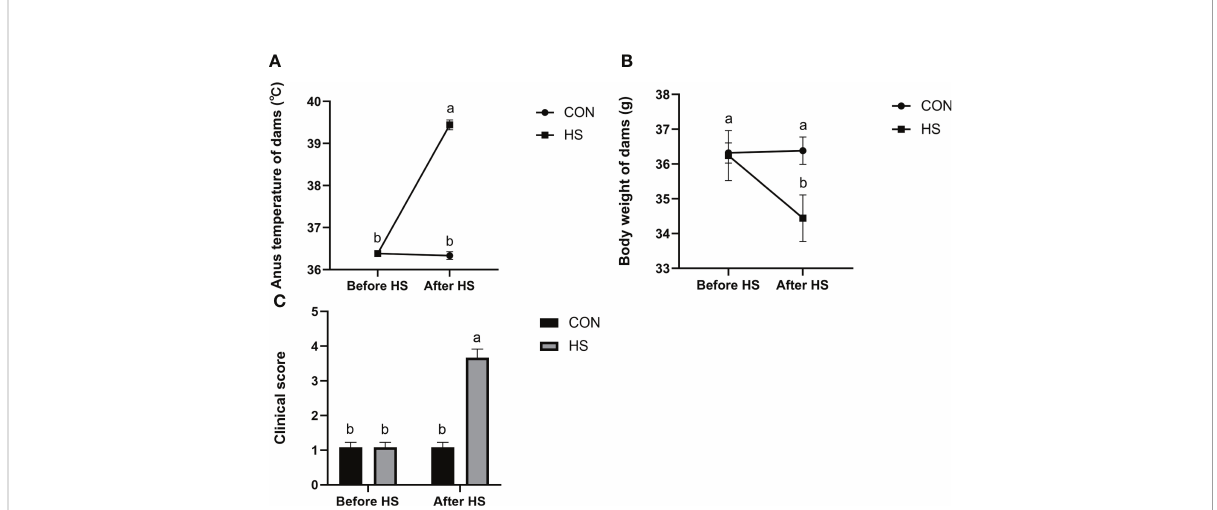
FIGURE 3 Effects of HS on anus temperature, dehydration degree, and clinical score of mice (n = 12). (A) Anus temperature. (B) Dehydration degree. Dehydration degree was described by changes in the body weight of the mice. (C) Clinical score. a-b Different lowercase letters indicate extremely signi fi cant differences between two groups ( P < 0.01), while the same lowercase letters indicate no signi fi cant difference between two groups ( P >